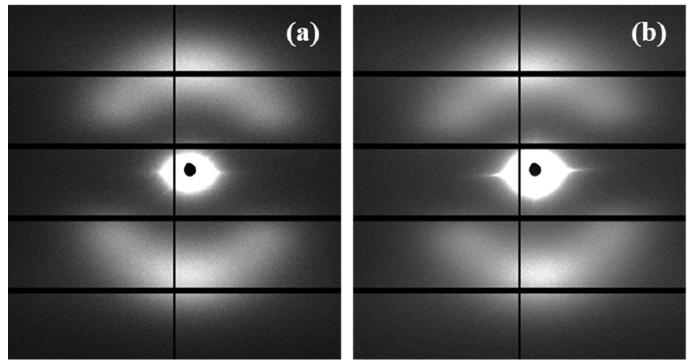
Figure 12. SAXS patterns of suture exposed to Pseudomonas cepacia ( a ) and Rhizopus oryzae ( b ) media at 37 °C for 14 days.